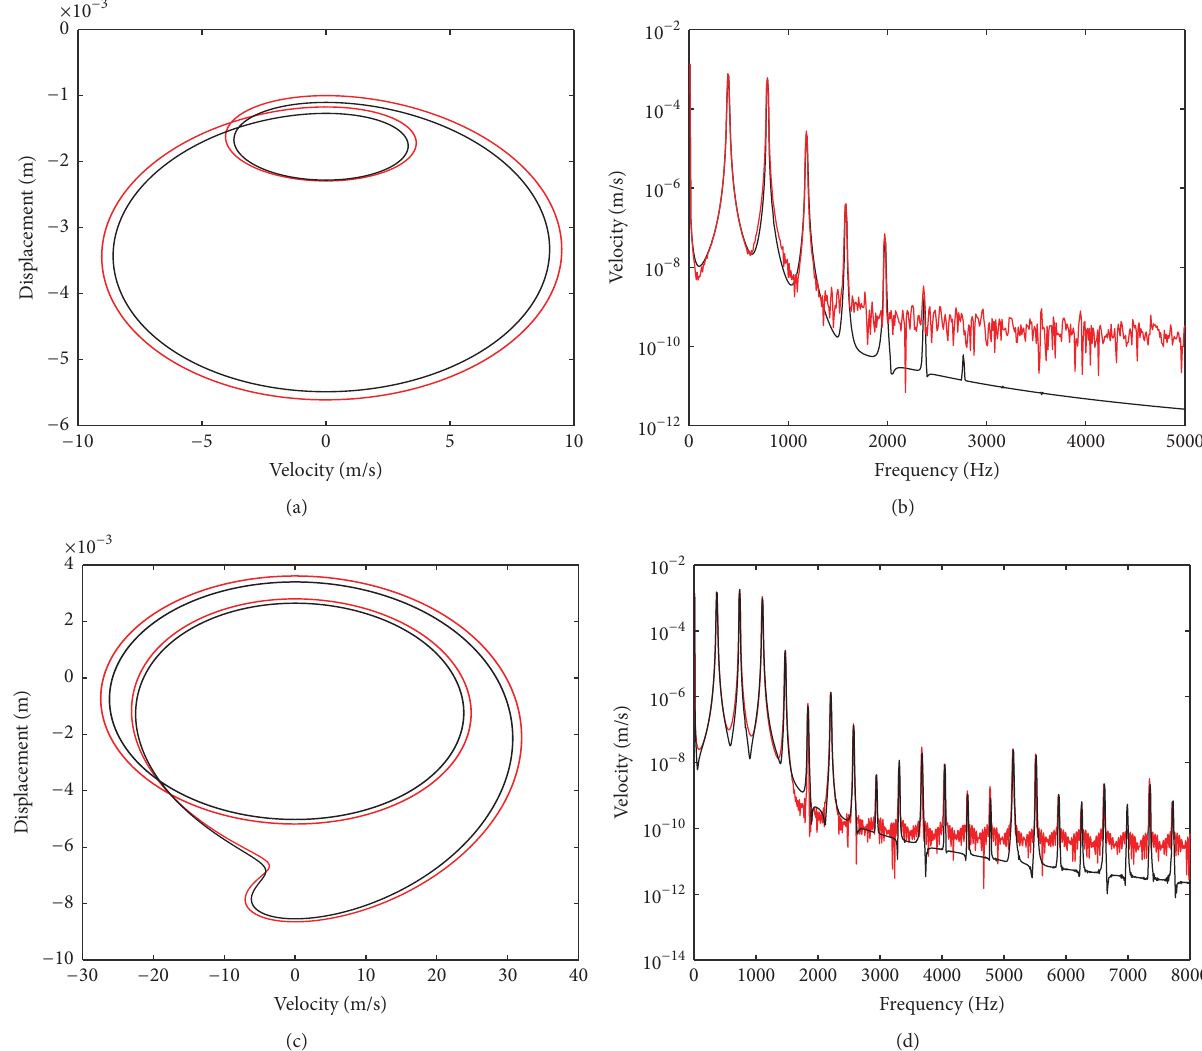
Figure5:LimitcyclesandFastFourierTransformonthestationaryself-excitedvibrationsforonedegree-of-freedomofthediscatthenormal component: (a, b) 𝜇 = 0.5 , (c, d) 𝜇 = 0.6 , (a, c) limit cycles, and (b, d) FFT, black color for the reference and red color for the reduced model with 15 interface modes.